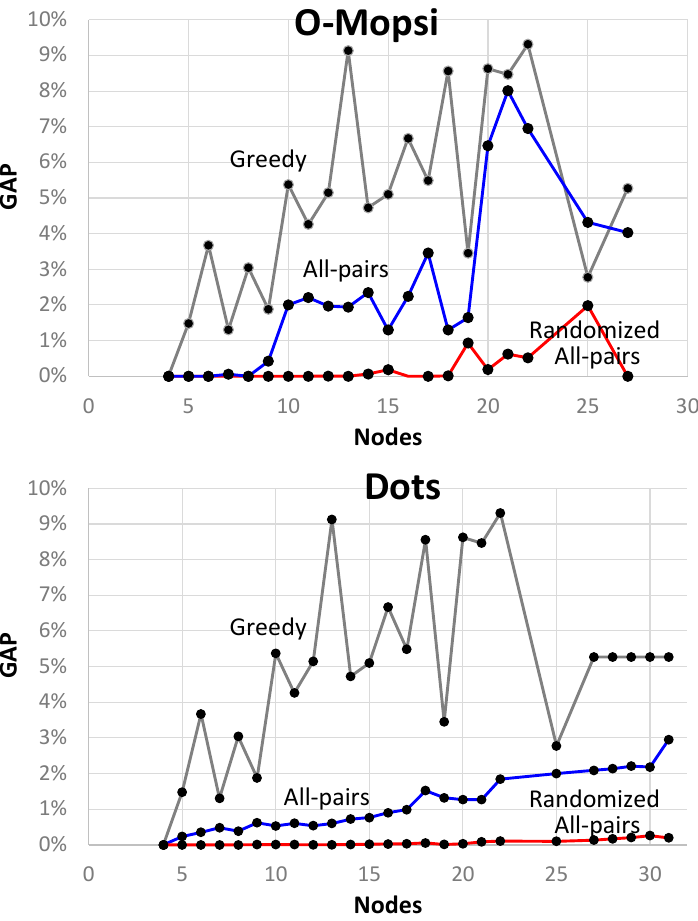
Figure 15. Results for the O-Mopsi and Dots as a function of the problem size.